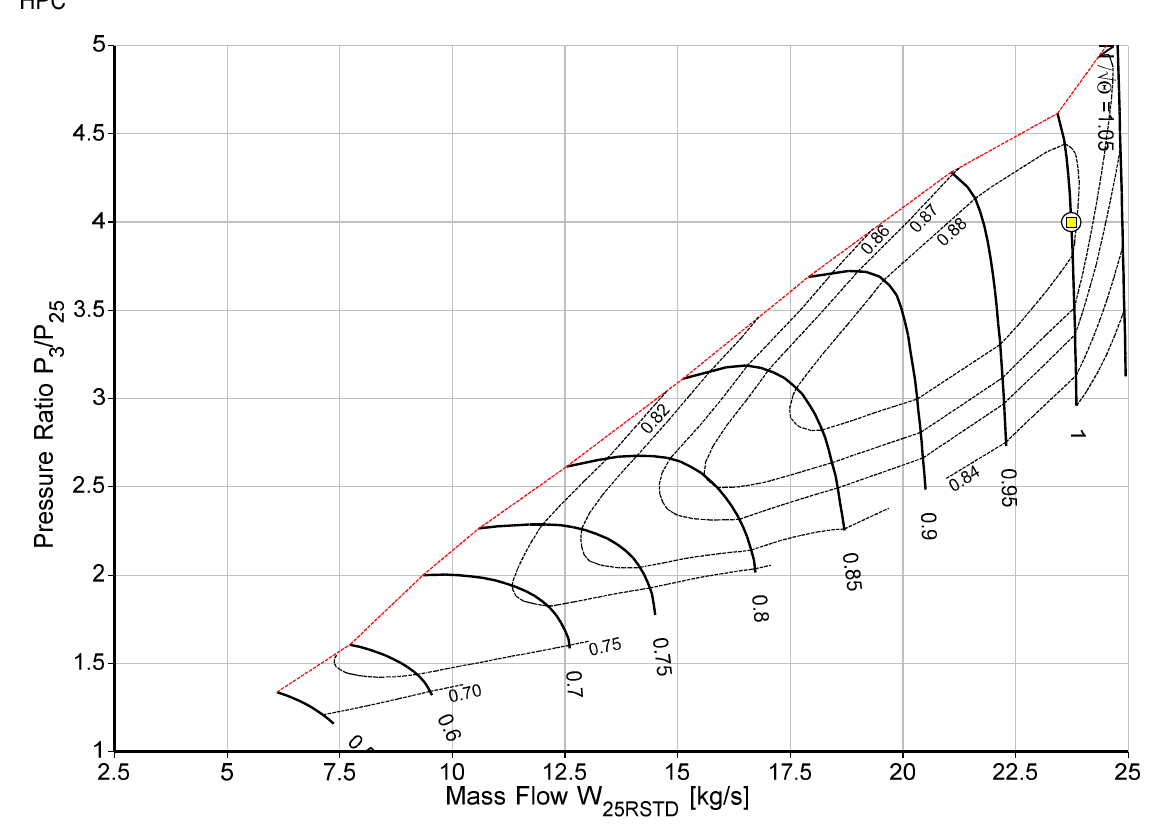
Figure 3. High-pressure compressor scaled map. Table 3. Parameters to be optimized.